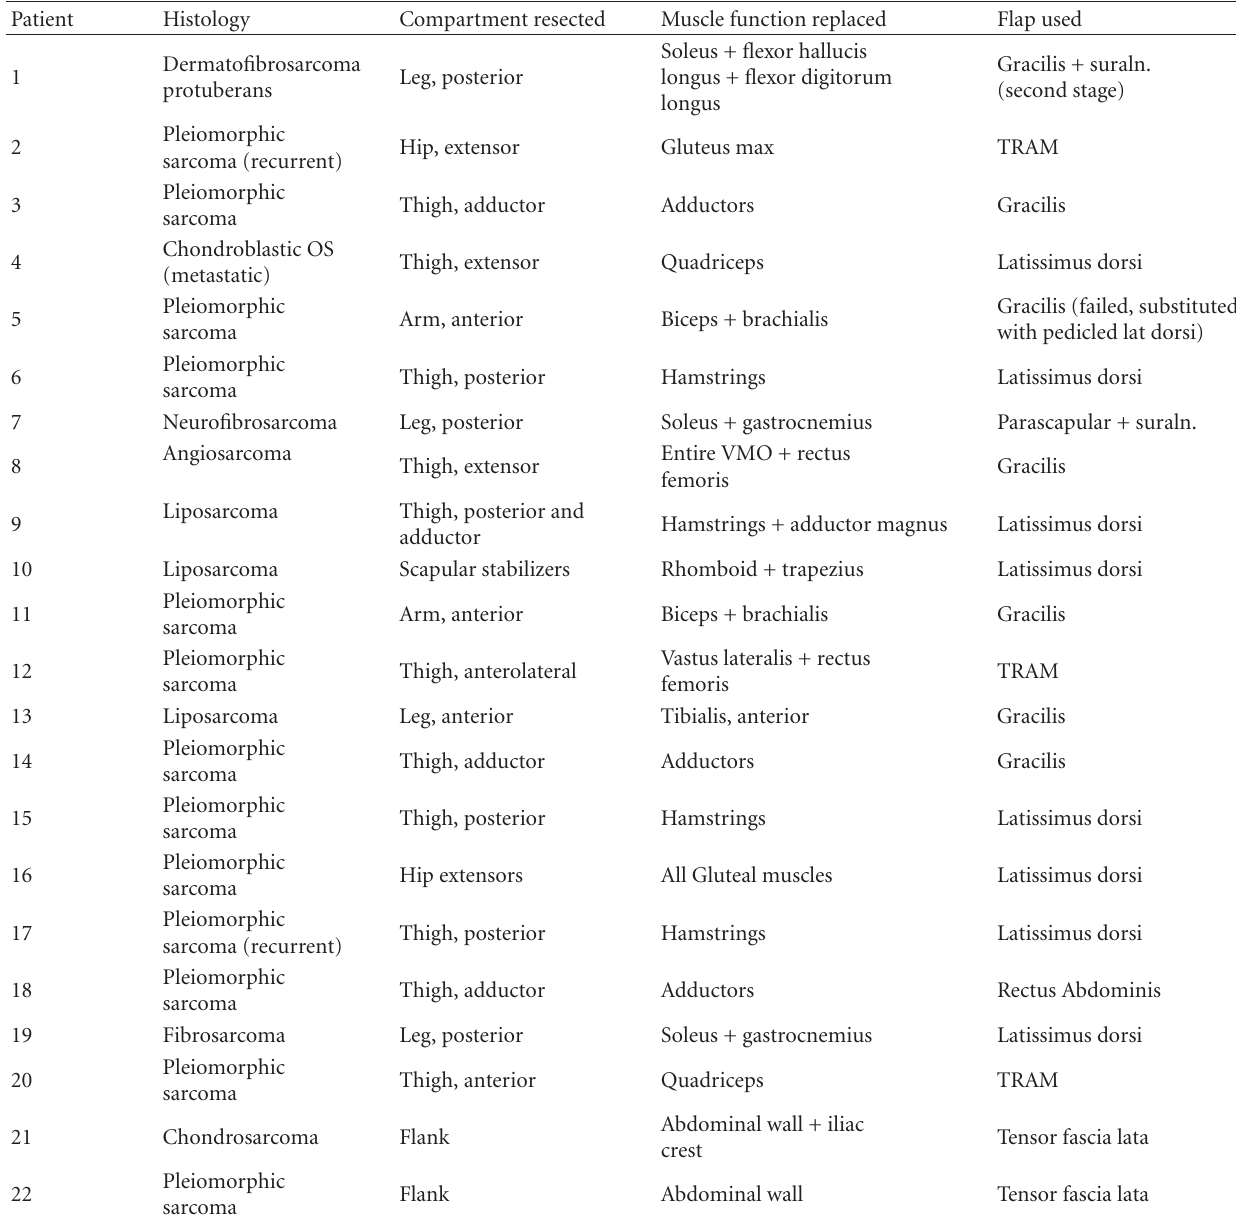
Table 1: Patients distributions regarding histology, compartment involved in the resection, muscle function replaced and flap